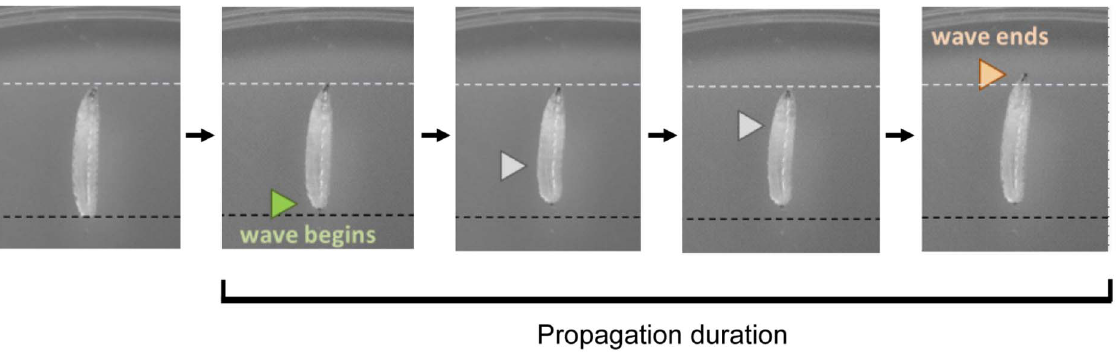
Figure 1. Behavioral analysis (locomotion analysis). To measure larval propagation duration, we videotaped the animals’ behavior using a CCD camera (30 frames/sec for 30 seconds). We manually calculated the duration of waves (10 waves per larva) using ImageJ